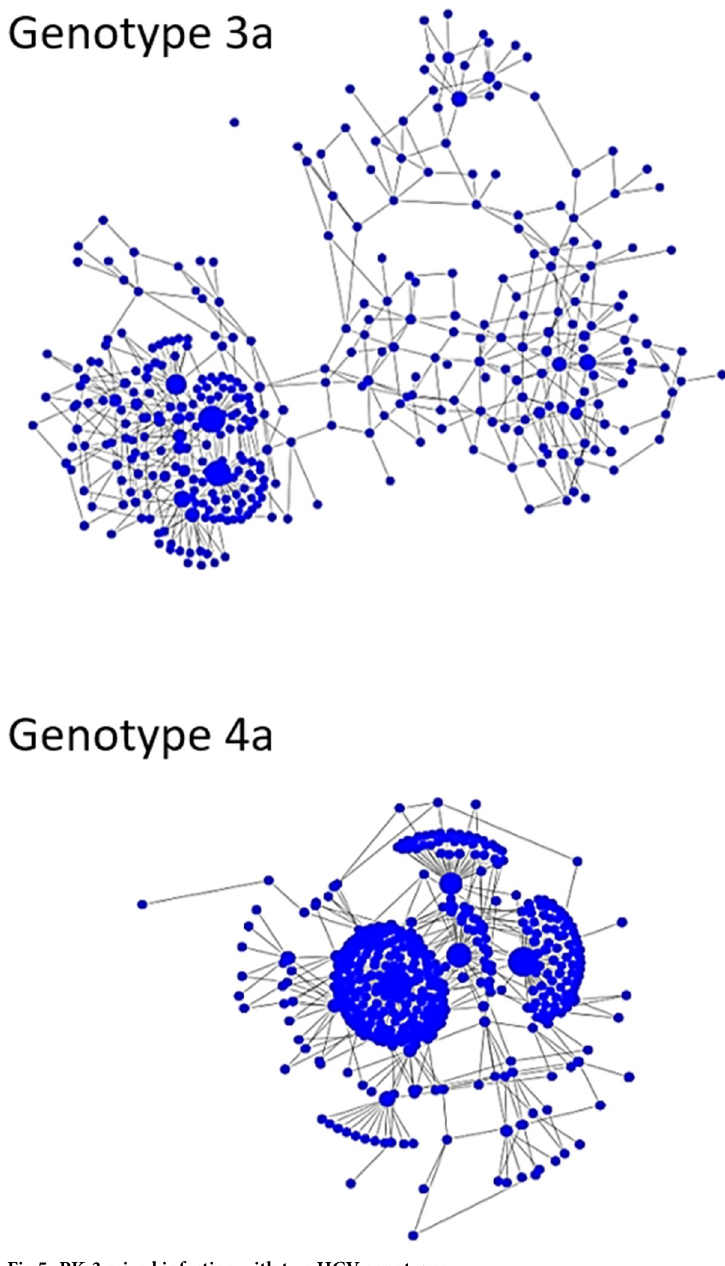
Fig 5. PK-3 mixed infection with two HCV